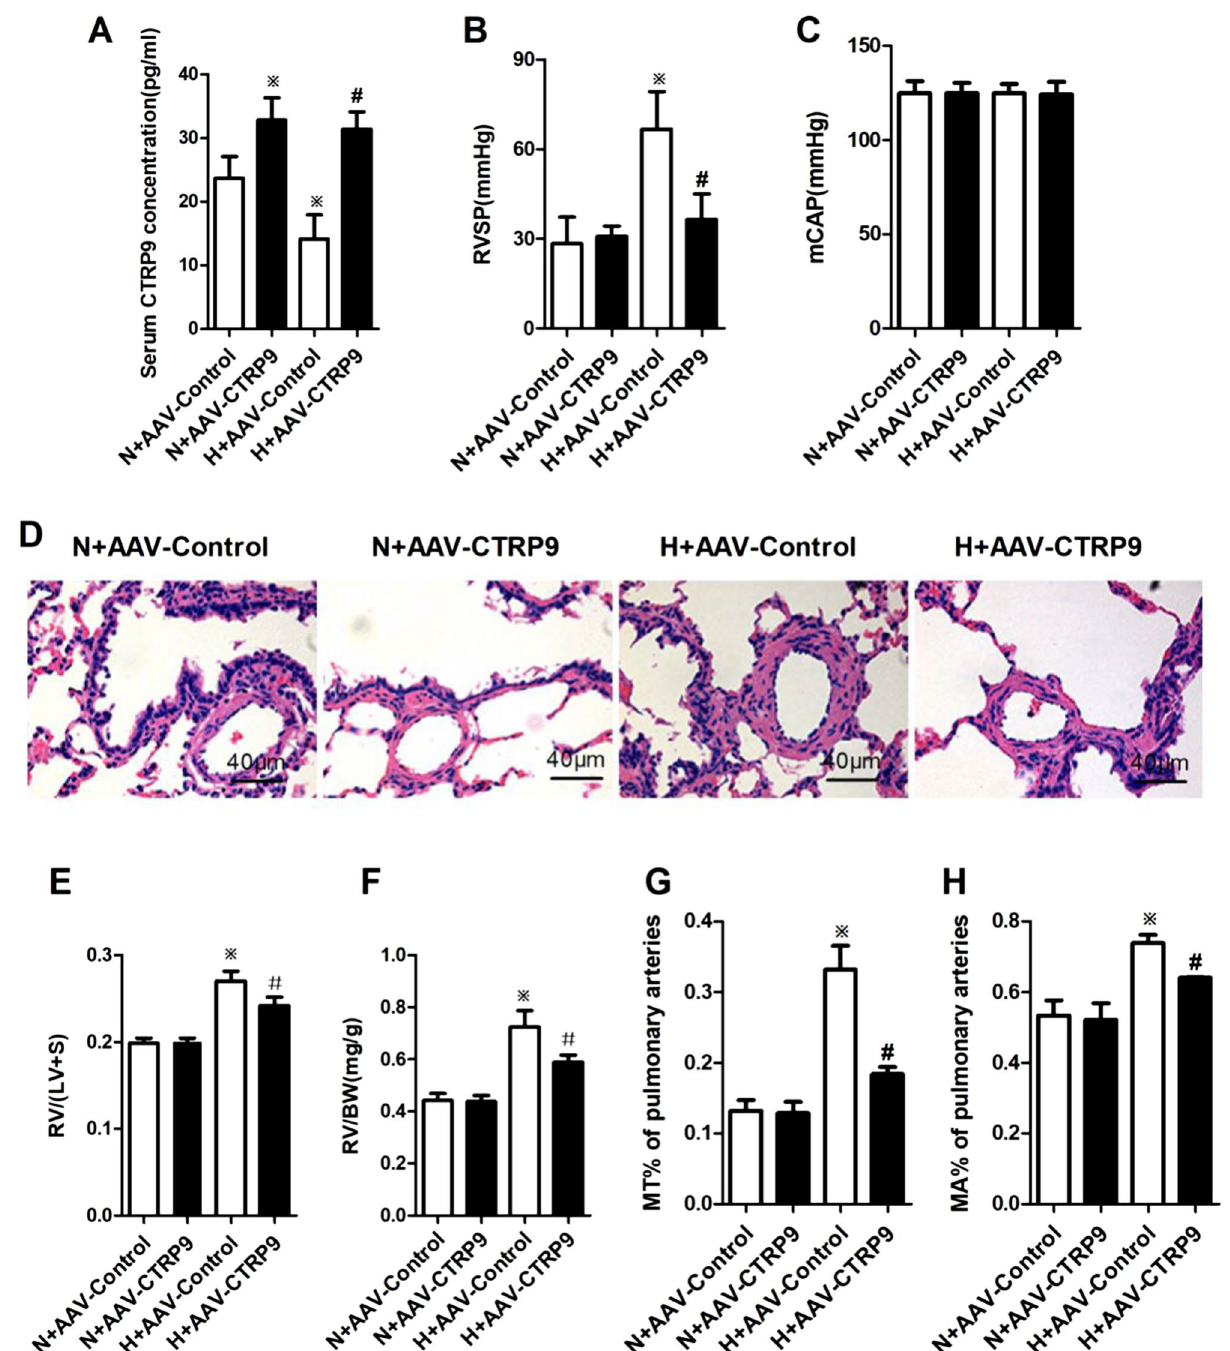
Figure 2. CTRP9 overexpression ameliorated HPH. ( A ) CTRP9 concentrations in rat serum are shown